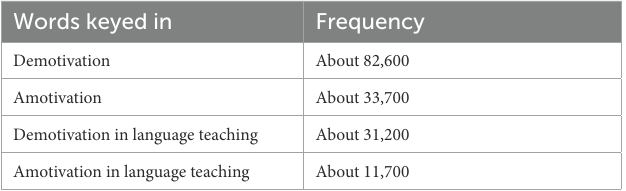
TABLE 1 Frequency of results from google scholar.